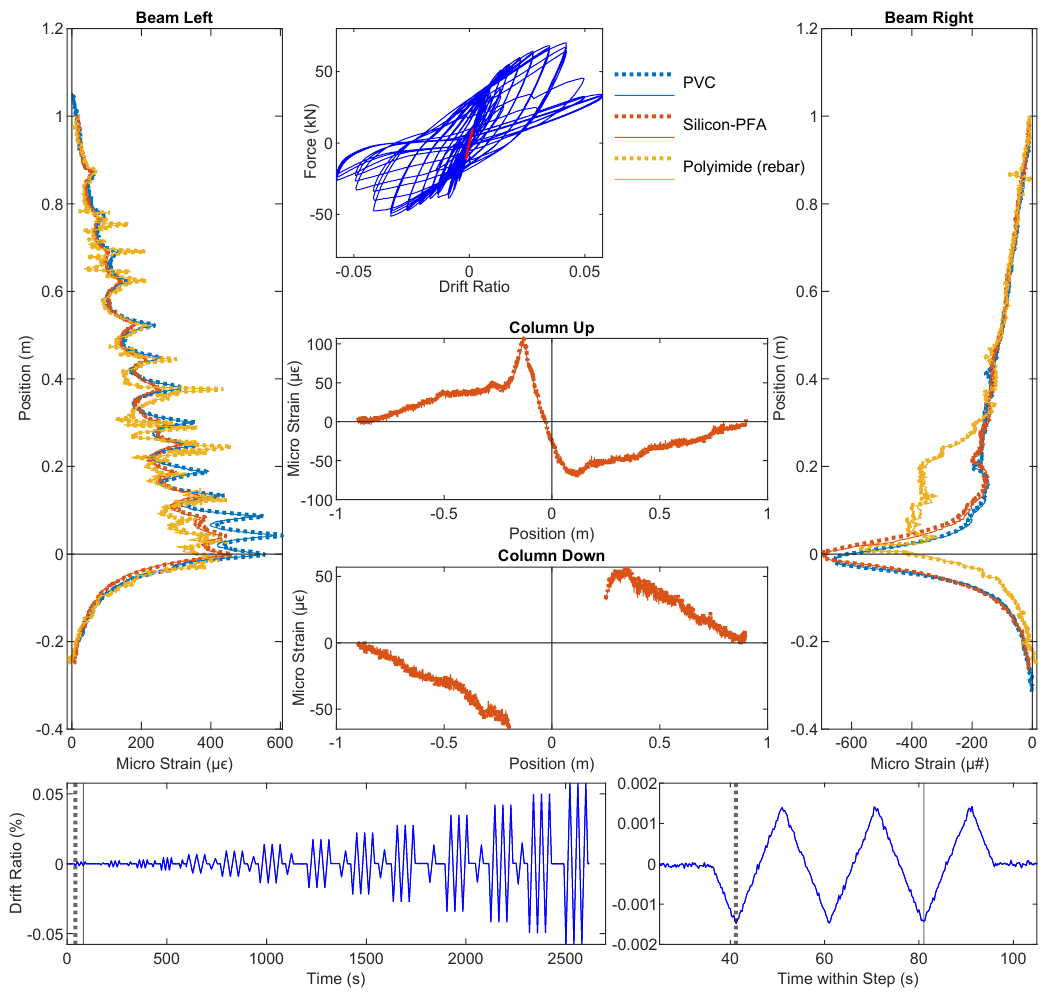
Figure 5. DFOS results at a drift level of −